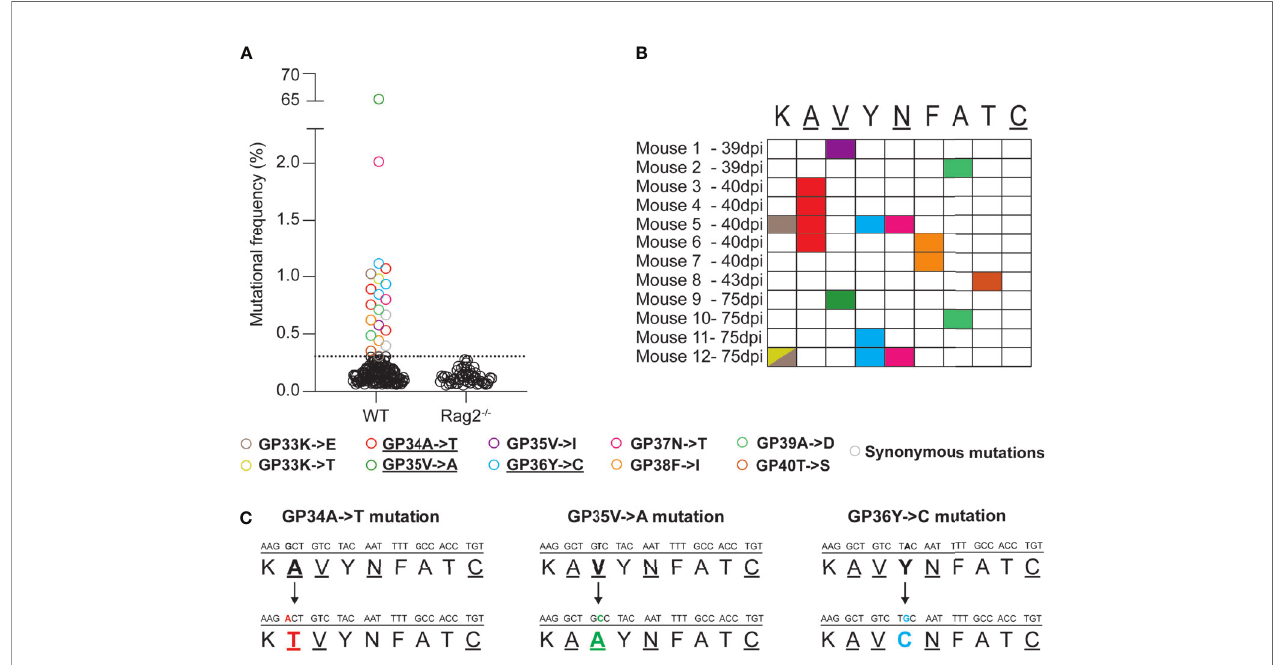
FIGURE 1 | Mutations emerge in the immunodominant GP33-41 epitope in LCMV CL13 WT in infected WT mice. (A) Mutations in the GP33-41 epitope identi fi ed in WT and Rag2 -/- mice using next-generation sequencing. The data from WT mice represents three, eleven, two and fi ve mice harvested at 39, 40, 43 and 75 days post infection respectively. These data are from six separate experiments. The data for the Rag2 -/- mice represent six and two mice harvested at 40 and 75 days post infection respectively. These data are from two separate experiments. The dotted line indicates the mean +3 standard deviations of the combination of the frequencies of all the mutations in the Rag2 -/- mice at both time points. (B) Schematic indicating the type and position, in the GP33-41 epitope, of the mutations identi fi ed in mice chronically infected with LCMV CL13 WT. (C) Diagram of the mutations identi fi ed repeatedly (GP34A->T and GP36Y->C) or at high frequency (GP35V->A) in the WT mice. The underlined amino acids are anchor residues.